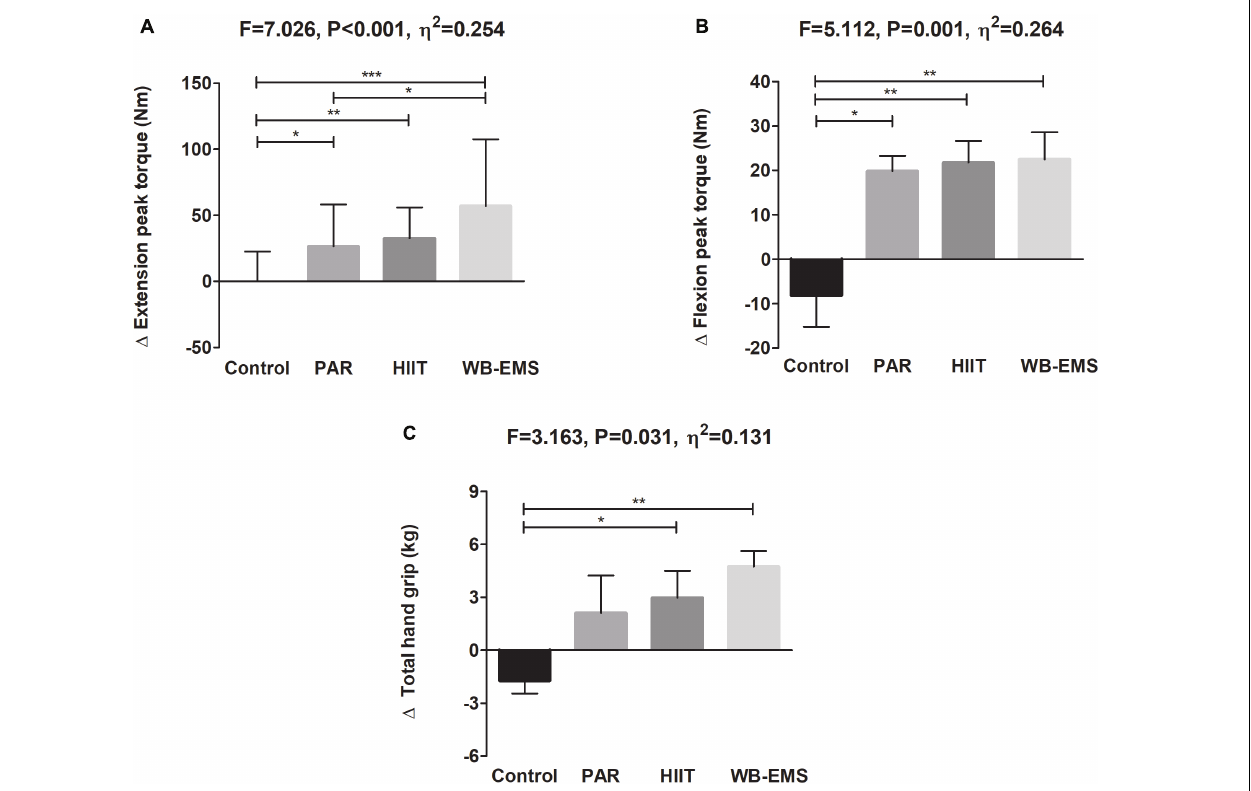
FIGURE 6 | Changes in extension peak torque (A) , flexion peak torque (B) , and total hand grip (C) after the intervention study among the four groups. Data are shown as means ± standard deviation. Parallel bars indicate significant differences between groups applying an analysis of covariance adjusting by baseline values, with post hoc Bonferroni-corrected t -test ( ∗ P < 0.05, ∗∗ P < 0.01, ∗∗∗ P < 0.001). PAR, physical activity recommendations for adults proposed by the World Health Organization group; HIIT, high intensity interval training group; WB-EMS, whole-body electromyostimulation